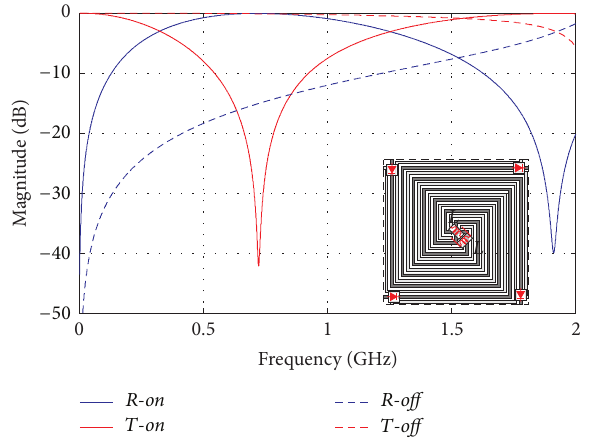
Figure 9: Transmittance and reflectance at normal incidence of the AFSS with the unit cell of Figure 8 when ideal pin diode switches are in the on and off states.